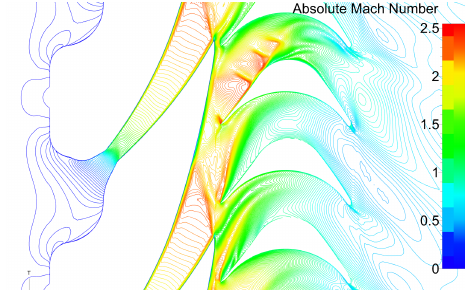
Figure 6. Isolines of Mach number. Figure 7. Complete model of the cantilever micro- turbine.